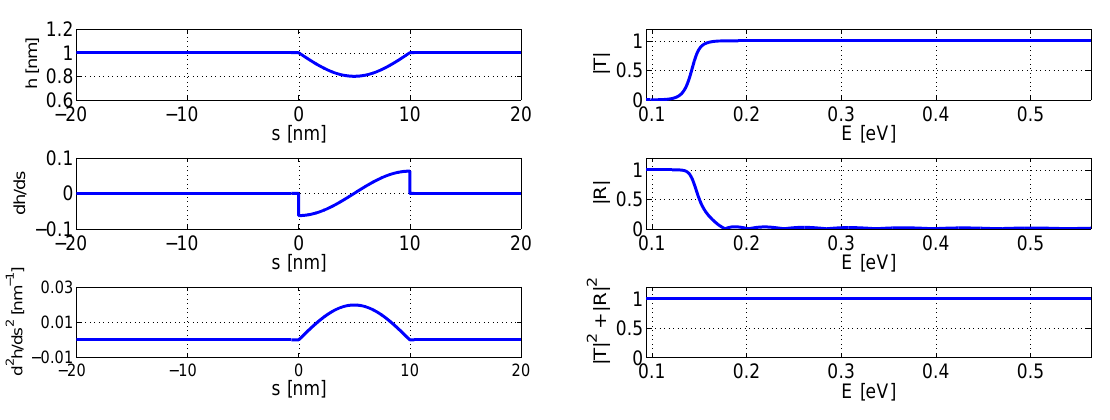
Figure 3. The case h 0 = 1nm, b = − 2Å, L m = 10nm, and n = 1, (cid:101) =